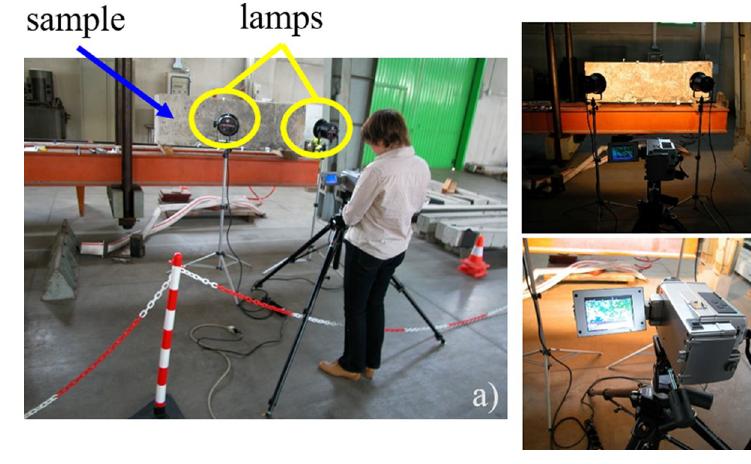
Table 1 Different steps of carrying out the thermographic analysis during heating and cooling